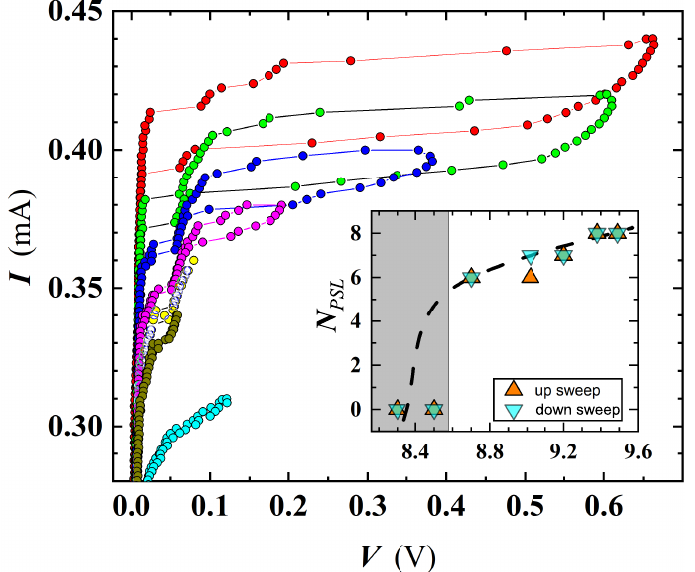
Figure 13. I-V characteristics of MO5b, showing the occurrence of steps in the curves close to T c , progressively disappearing approaching T c . The T values for the shown curves are: 8.70 K (red), 9.02 (green), 9.20 K (blue), 9.38 K (magenta), 9.49 K (yellow), 9.60 K (olive), 9.98 K (cyan). Inset: number of TAPS extracted from I-V curves. The gray rectangle defines the T range where no PSL were detected.